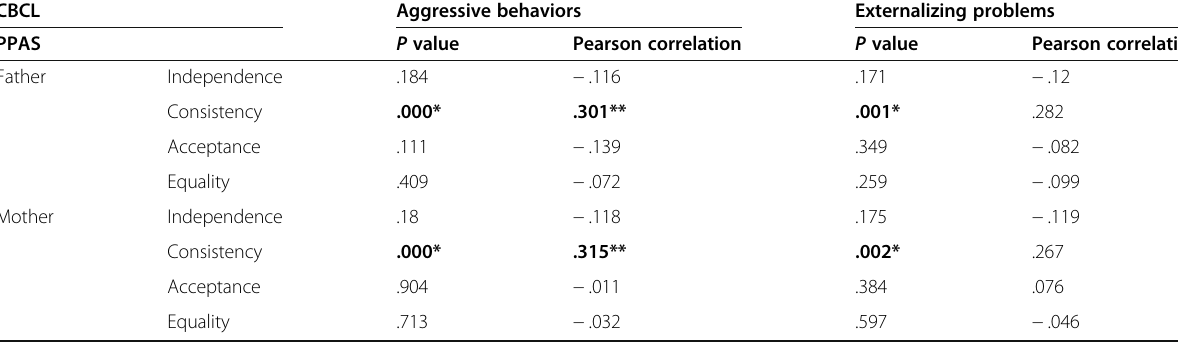
Table 3 Correlation between perceived parenting attitudes and disruptive behaviors in ADHD children CBCL Aggressive behaviors Externalizing problems Pearson correlation Pearson correlation